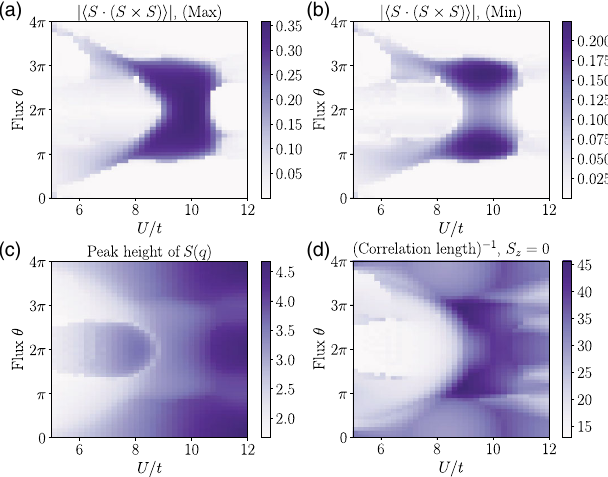
FIG. 9. YC5 cylinder with flux insertion θ , for χ ¼ 4000 . (a) Absolute value of the chiral order parameter; at finite bond dimension, the translation symmetry is broken along the cylinder, and here we show the larger of the chiral order parameters between the two distinct rings. The chiral phase exists at intermediate U when θ is approximately in the range π – 3 π . (b) The smaller of the two chiral order parameters. (c) Maximum of the h S z S z i structure factor in the Brillouin zone. (d) Inverse correlation length for excitations with S z ¼ 0